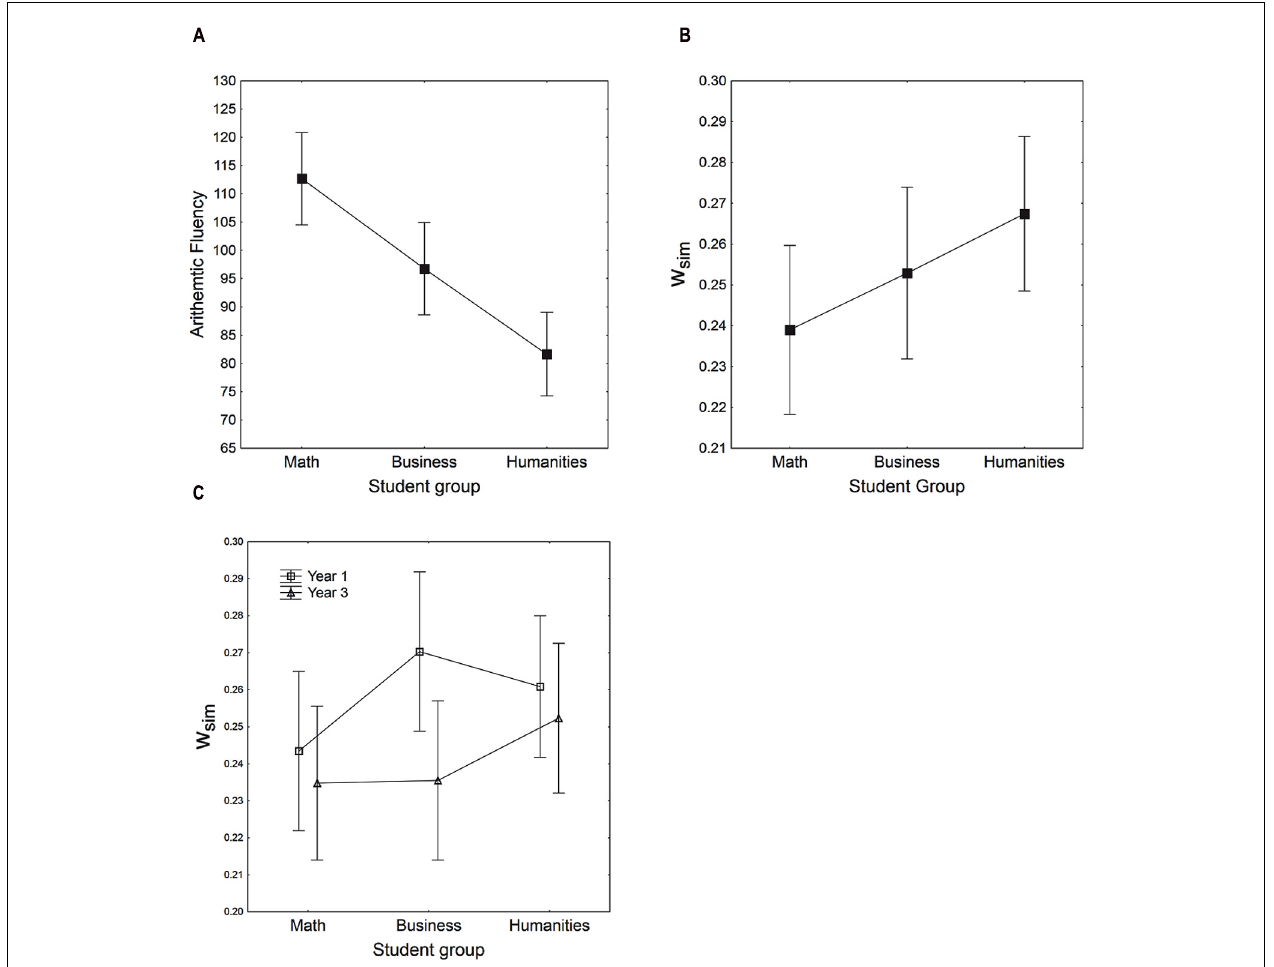
FIGURE 1 | (A) Overall arithmetic fluency (OAF) as a function of student group. (B) Simultaneous ANS acuity w sim as a function of student group. (C) Simultaneous ANS acuity w sim as a function of student group and year of study (Year 1 orYear 3).The y-axes do not start from 0.Vertical bars denote 95% confidence intervals.